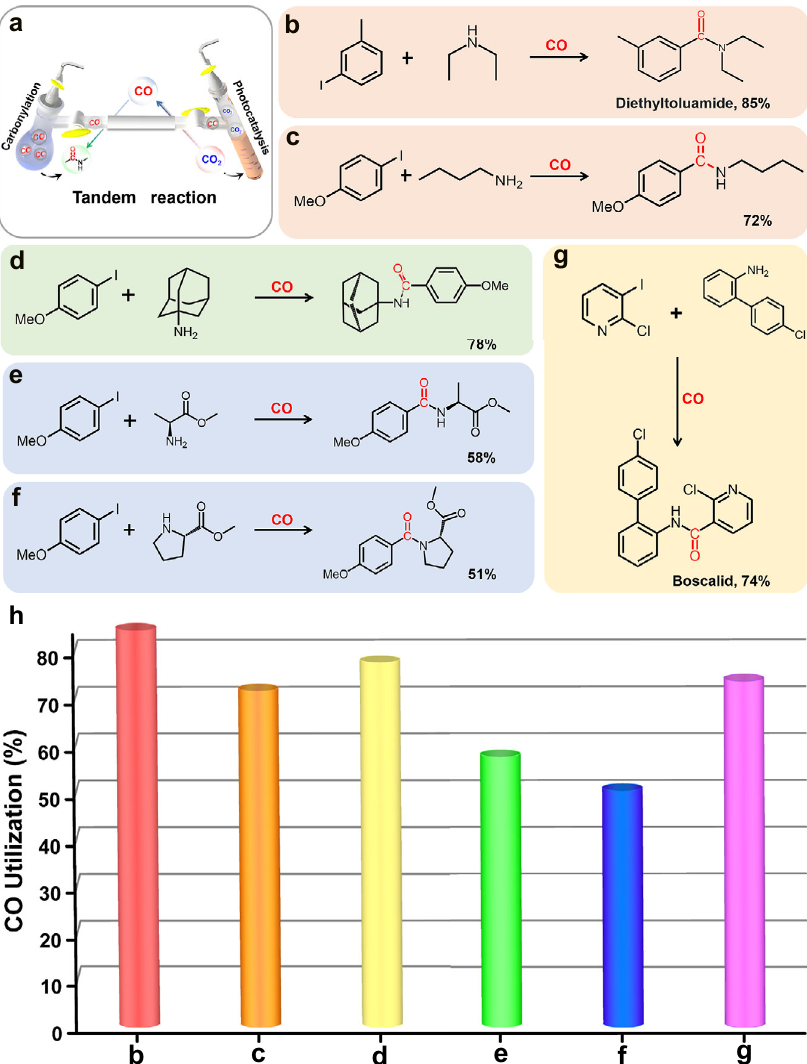
Fig. 7 Application of the photocatalytic CO 2 RR to aminocarbonylative coupling. a Schematic illustration of the experimental apparatus and device structure. b – g Synthesis of pharmaceuticals molecules, fi ne chemicals, and other biologically active molecules. h The tandem reaction showed the different CO utilization for different reaction